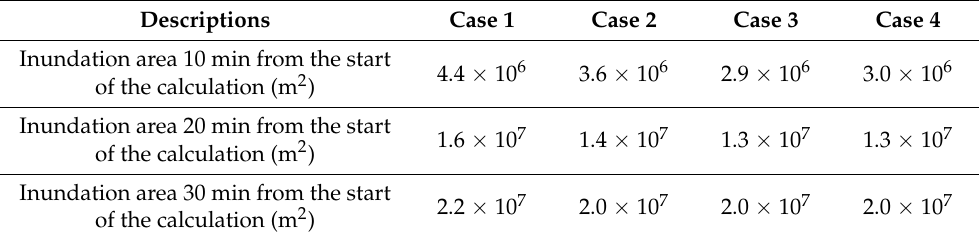
Figure 31. (Case–4). Inundation height, 30 min after start of the calculation. Table 3. Inundation area under different dam-break